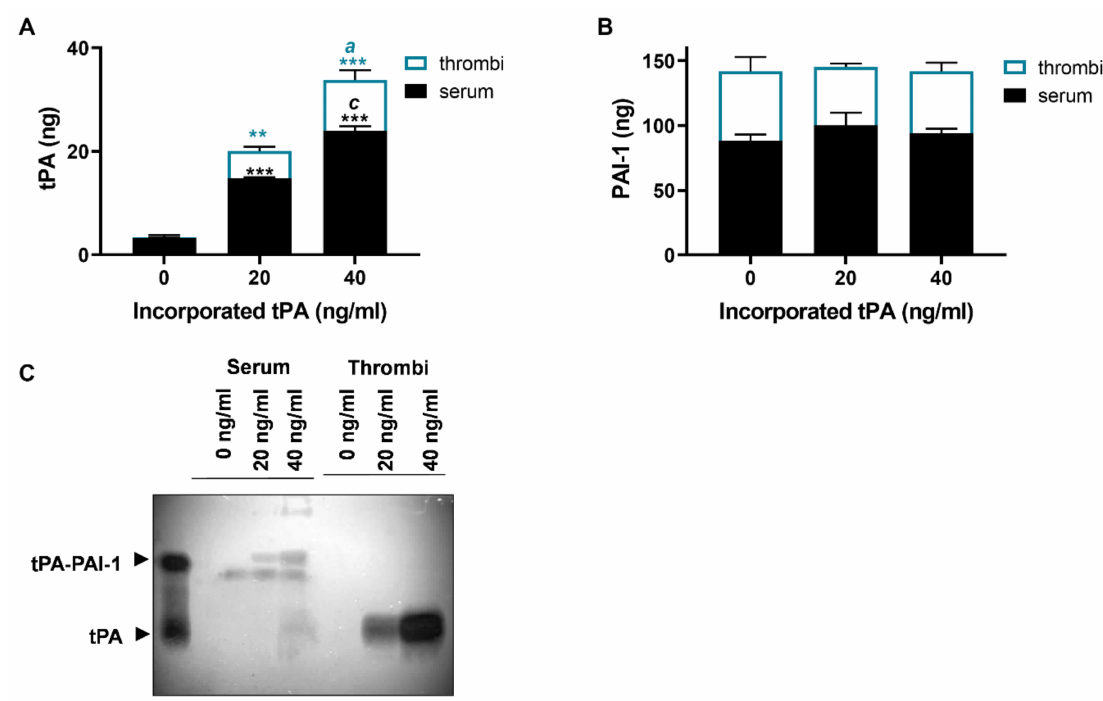
Figure 2. tPA incorporated into thrombi is protected from PAI-1 inhibition. Chandler model thrombi were formed and the levels of ( A ) tPA, and ( B ) plasminogen activator inhibitor-1(PAI-1) in serum and thrombus extracts were measured by ELISA. ( C ) Detection of tPA by zymography showing tPA and tPA–PAI-1 in the serum and thrombus extract after incorporation 0, 20 or 40 ng/mL tPA. Data shown are mean ± SEM ( n = 4). ** p < 0.01, *** p < 0.001 vs. no tPA, a p < 0.05, c p <